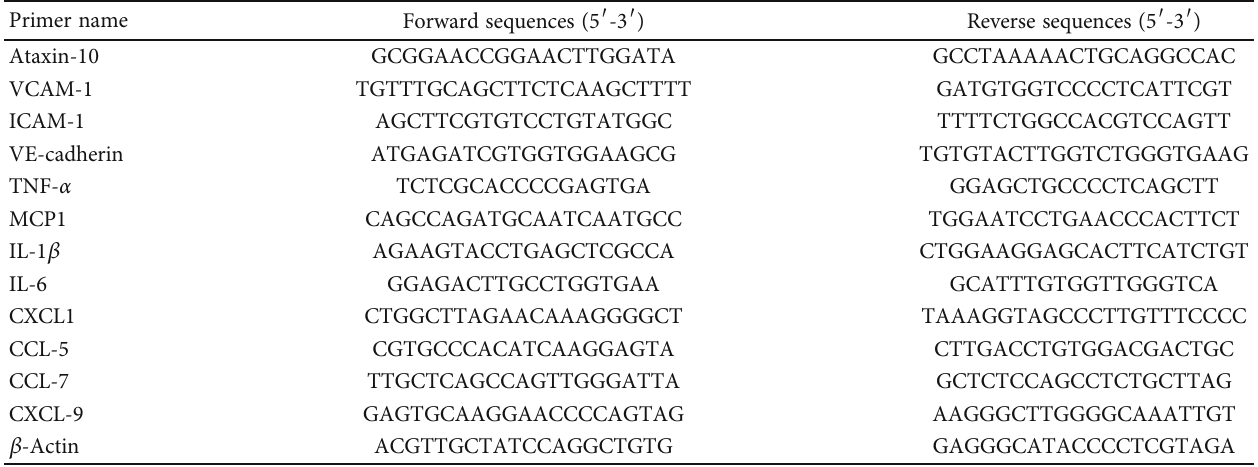
Table 1: Sequences of qPCR primers used in this